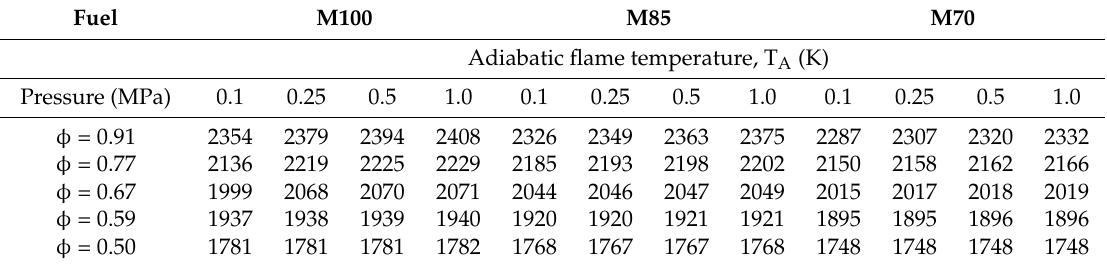
Table 5. Adiabatic flame temperature at elevated pressures and T sub = 630 K (SanDiego). Fuel M100 M85 M70 Adiabatic flame temperature, T A (K) Pressure (MPa) 0.1